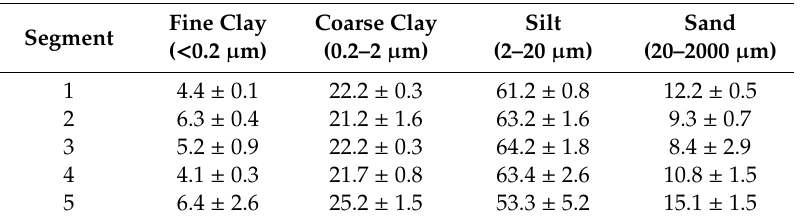
Table 2. Soil texture fractions (per cent by weight) determined using an ultrasonic particle analyzer. The values are mean ± standard deviation ( n =